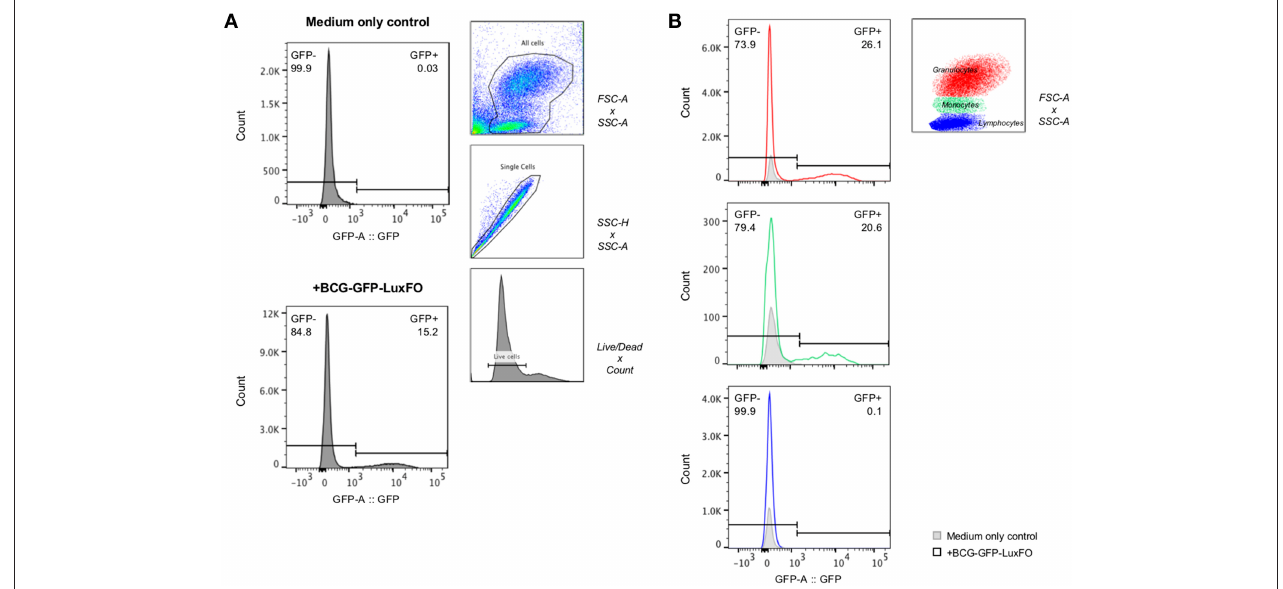
FIGURE 5 | Flow cytometric detection of fluorescence of BCG-GFP-LuxFO in whole blood assay. (A) Within the live cell population, GFP– and GFP + cells were determined, respectively. (B) Within the live cell population, cells were then gated on either granulocytes (in red), monocytes (in green), or lymphocytes (in blue), distinguishable by their size and granularity using forward scatter (FSC)/side scatter (SSC) gate. The gate GFP–/GFP + populations were set based on the medium only negative control so that the frequency of GFP + cells = 0% for each cell population. For each plot, the GFP- population is reported in the top left, and the GFP + population in the top right. Representative data shown from samples from two children one hour after BCG-GFP-LuxFO was added.